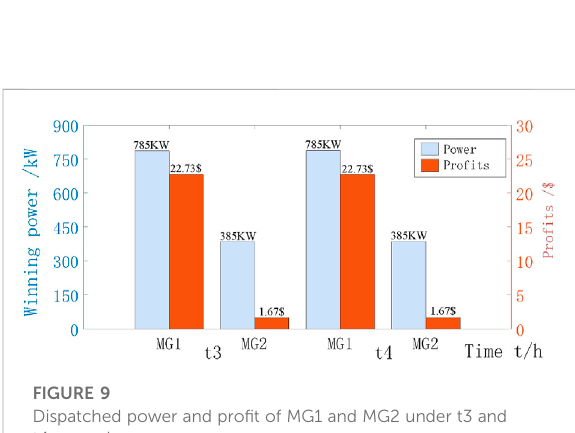
FIGURE 9 Dispatched power and pro fi t of MG1 and MG2 under t3 and t4